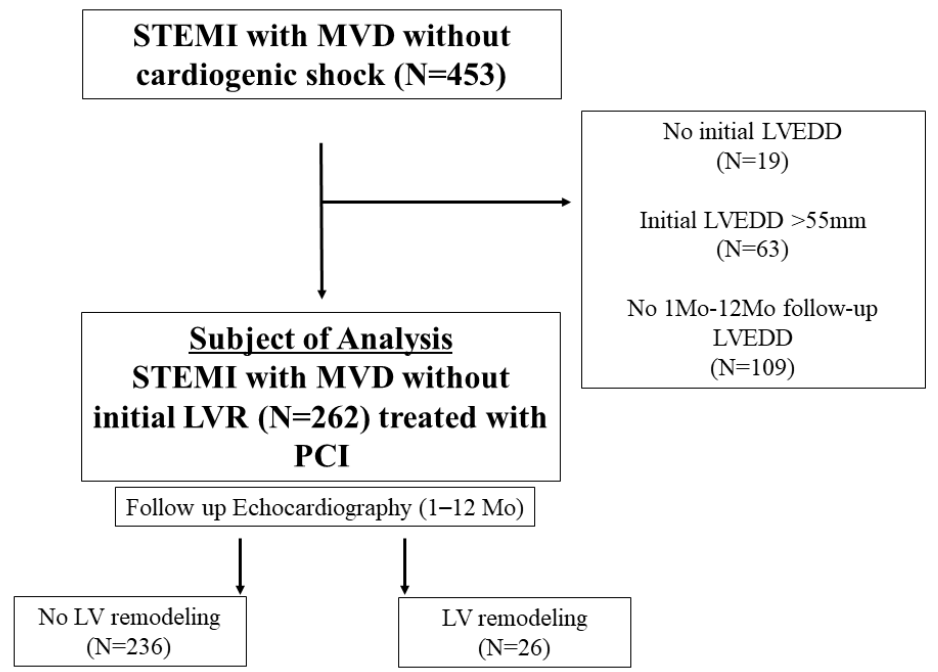
Figure 1. Study flow. LV= left ventricular; LVEDD= left ventricular end-diastolic diameter; LVR= left ventricular remodeling; MVD= multivessel disease; PCI= percutaneous coronary intervention; STEMI= ST segment elevation myocardial infarction